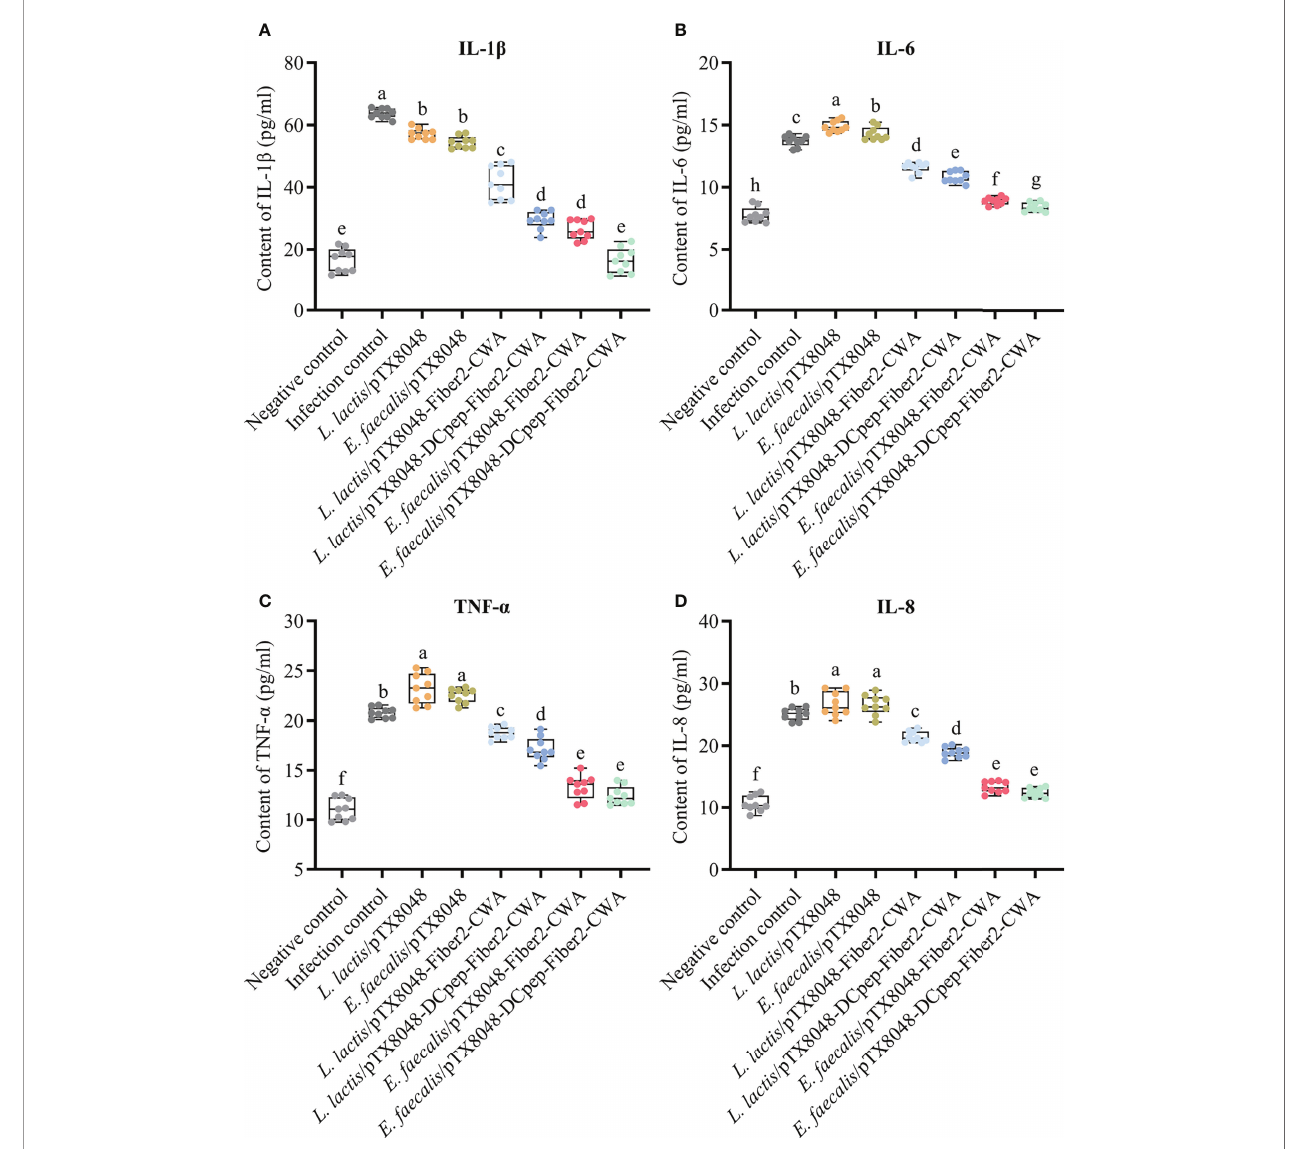
FIGURE 7 | Detection of in fl ammatory factors in livers of chickens at 5 days postinfection. The levels of in fl ammatory factors IL-1 b (A) , IL-6 (B) , TNF- a (C) , and IL-8 (D) in the livers of chickens (n = 3) from each group were determined by ELISA. Each sample was tested in triplicate. Different small letters denote signi fi cant differences among groups ( p <